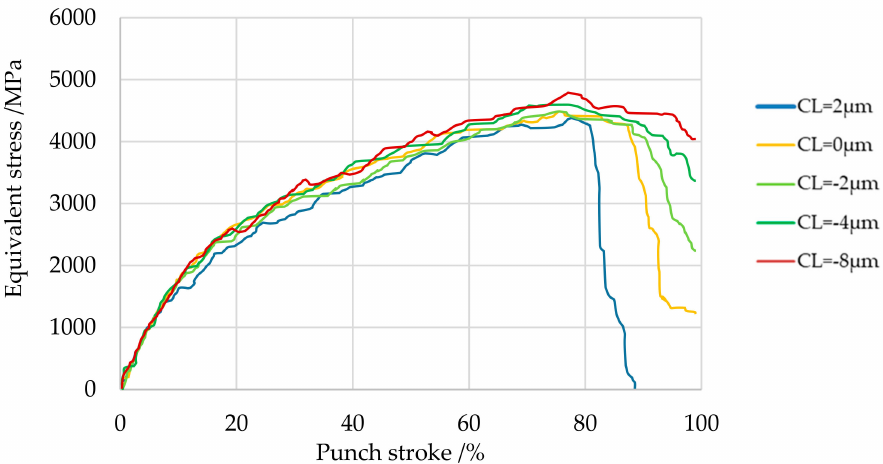
Figure 10. Equivalent stress at Point A at the tip of the punch for various